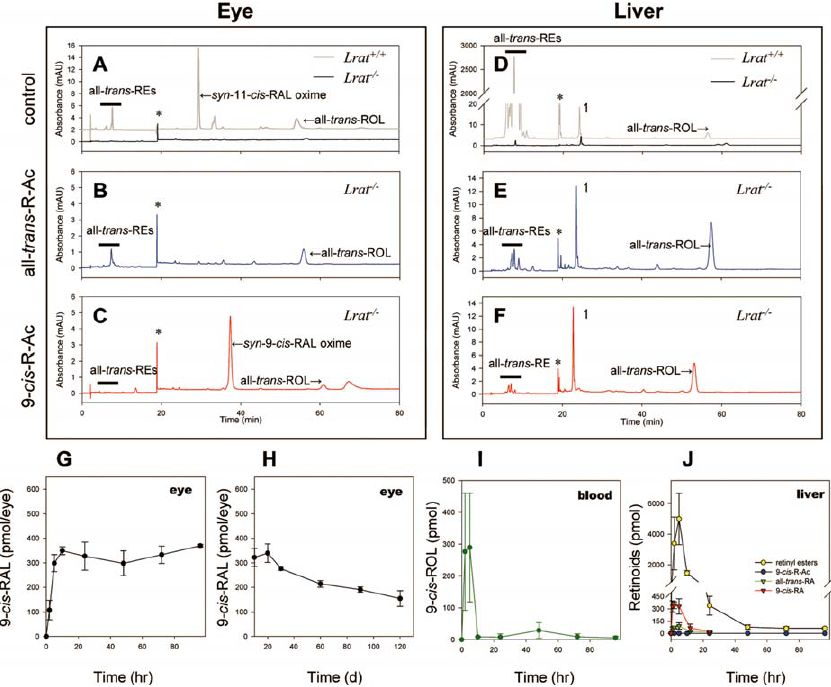
Figure 2. Retinoids in the Liver and Eyes of Lrat (cid:2) / (cid:2) Mice after 9- cis -R-Ac Treatment (A–F) Normal-phase HPLC analysis of nonpolar retinoids extracted from the tissues of dark-adapted Lrat þ / þ or Lrat (cid:2) / (cid:2) mice following gavage with retinoids. Peaks marked * represent the solvent change artifact, and peaks labeled (1) indicate an unidentified non-specific compound with k max ¼ 270 nm. In all experiments, mice were dark-adapted for 48 h after gavage. Shown are results from eyes of dark-adapted control Lrat þ / þ (gray) and Lrat (cid:2) / (cid:2) mice (black) (A); eyes of dark-adapted Lrat (cid:2) / (cid:2) mouse gavaged with all- trans -R-Ac (B); eyes of dark-adapted Lrat (cid:2) / (cid:2) mouse gavaged with 9- cis -R-Ac (C); liver tissue from dark-adapted control Lrat þ / þ (gray) and Lrat (cid:2) / (cid:2) (black) mice (D); liver tissue from dark-adapted Lrat (cid:2) / (cid:2) mouse gavaged with all- trans -R- Ac (E); and liver tissue from dark-adapted Lrat (cid:2) / (cid:2) mouse gavaged with 9- cis -R-Ac (F). (G–J) Time course of the levels of nonpolar and polar retinoids in the tissues of Lrat (cid:2) / (cid:2) mice following gavage with 9- cis -R-Ac measured by HPLC. After gavage, mice were dark adapted for indicated time before HPLC analysis ( n (cid:4) 3, data shown with SD). The graphs depict: a short time course of 9- cis - RAL oxime levels detected in Lrat (cid:2) / (cid:2) mice eyes following a 20 l mol gavage of 9- cis -R-Ac (G); a longer time course of 9- cis -RAL oxime levels in Lrat (cid:2) / (cid:2) mice eyes following a 20 l mol gavage of 9- cis -R-Ac (H); time course of 9- cis -ROL blood levels in Lrat (cid:2) / (cid:2) mice following gavage with 20 l mol 9- cis -R-Ac (I); and time course of RE and RA levels in liver of Lrat (cid:2) / (cid:2) mice following a 20 l mol gavage with 9- cis -R-Ac (J). DOI: 10.1371/journal.pmed.0020333.g002